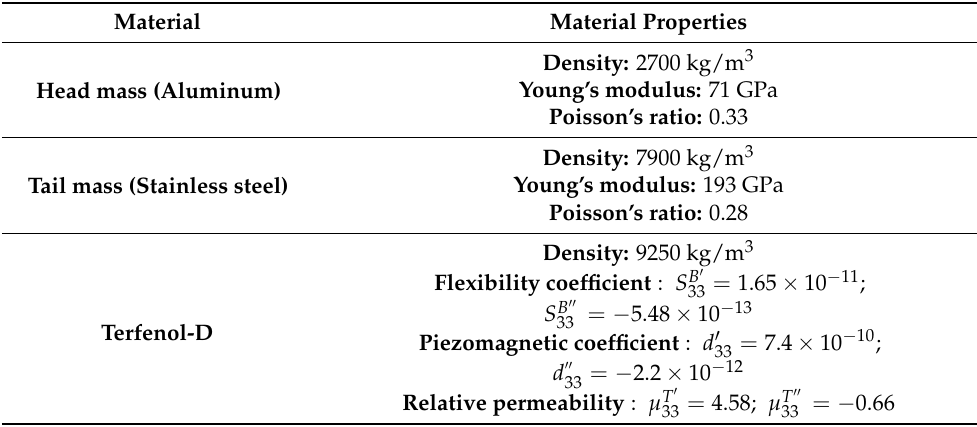
Table 3. Material properties of the Tonpilz